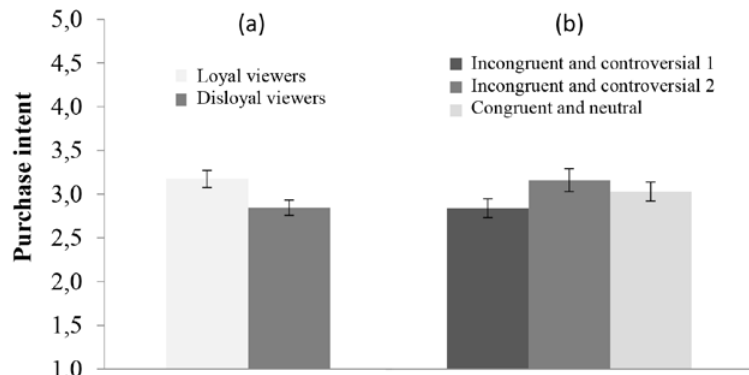
Figure 4. Differences in purchase intent for the advertised